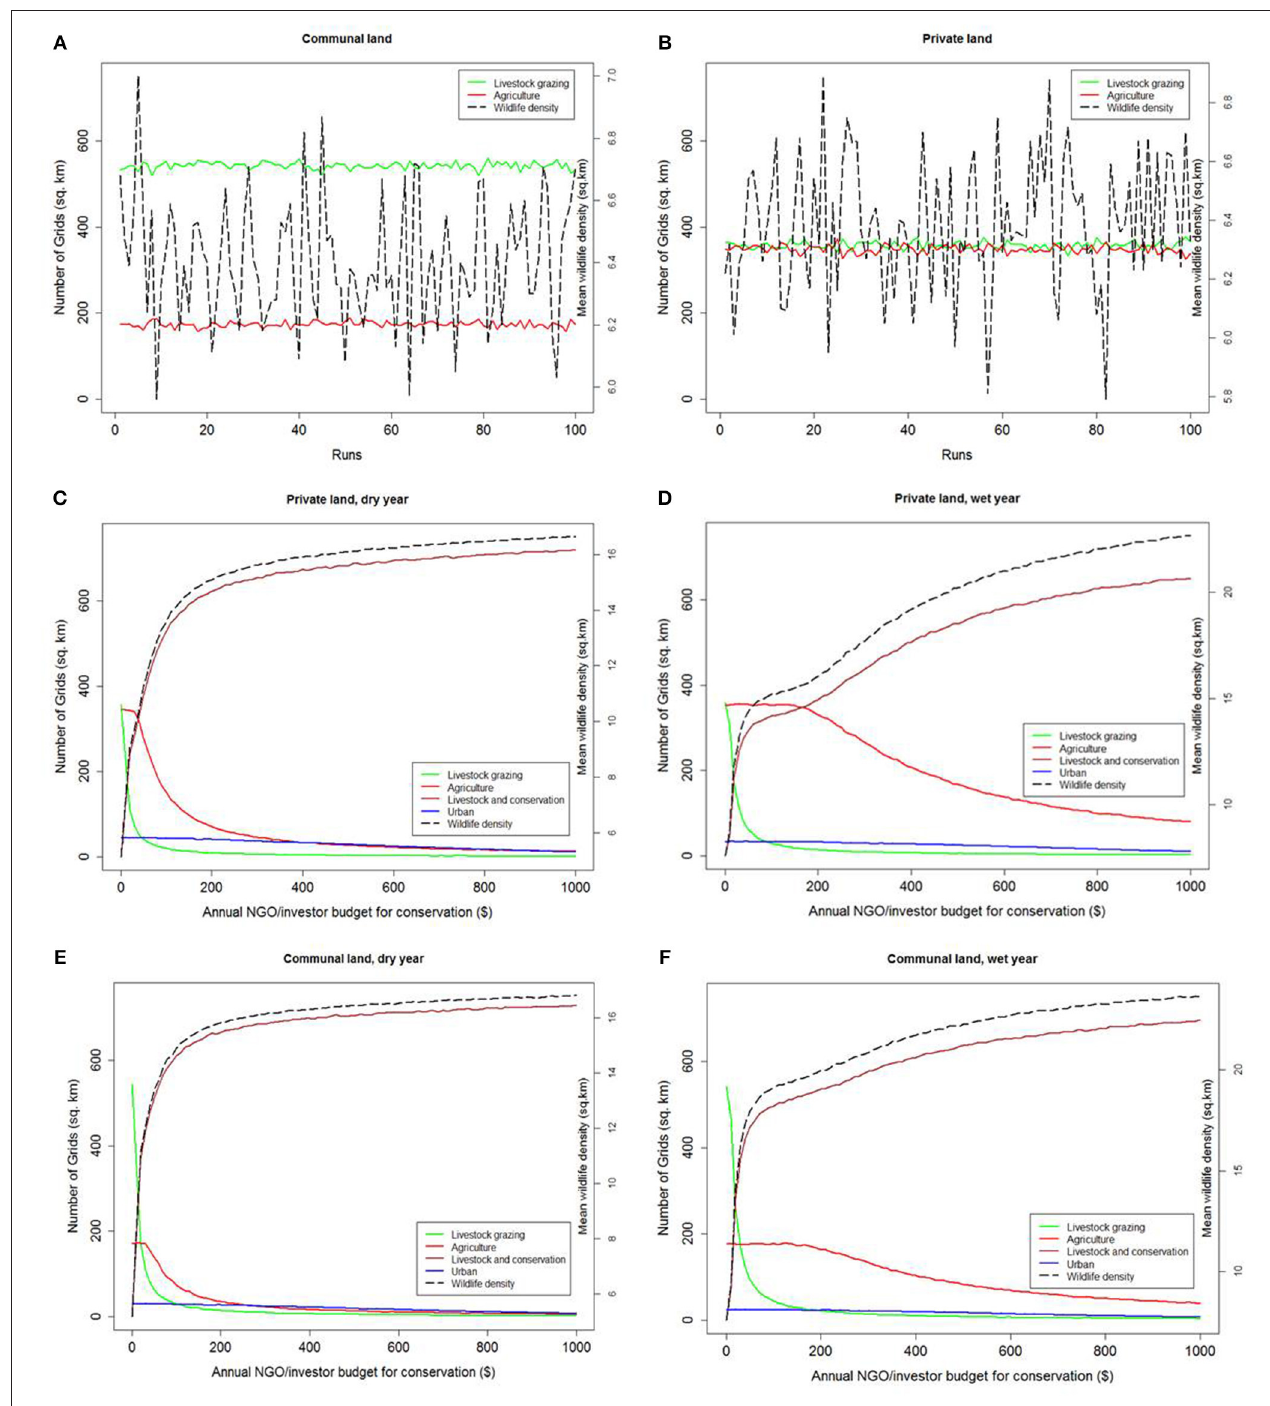
FIGURE 6 | The relationship between land use types and wildlife densities as simulated from a socio-ecological model. (A,B) Show the trends between livestock grazing, agriculture and wildlife densities in community and private land tenure in Amboseli. (C,D) Compare the relationship between land use types and wildlife density in private land between dry and wet rainfall years as Non-Governmental Organizations (NGOs) or investors into conservation initiatives in Amboseli invest more money. (E,F) Compare land use trends, monetary investment into conservation initiatives and wildlife density between dry and wet rainfall years in community land.